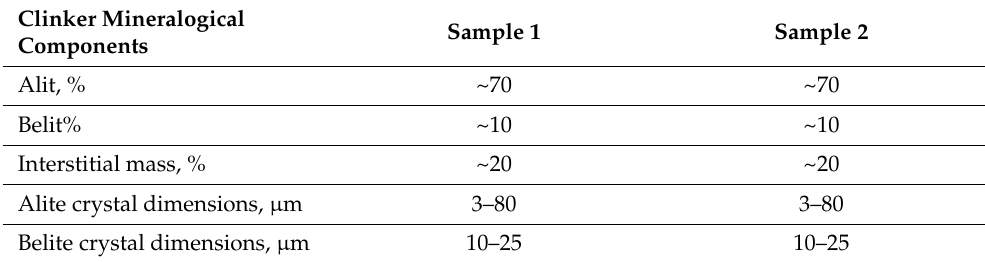
Table 3. Mineralogical composition of the clinker * resulting from preparation by light microscopy.